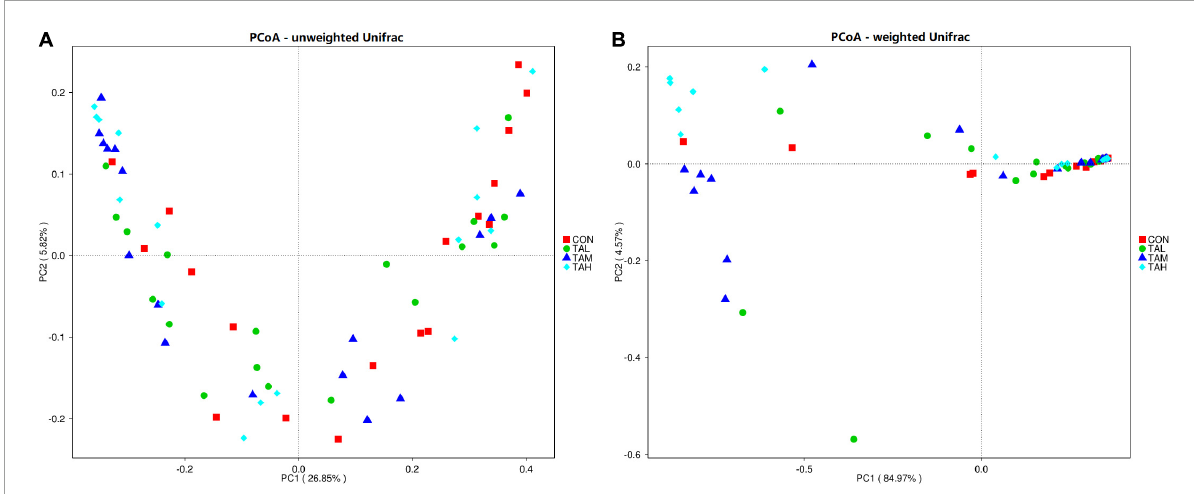
FIGURE1 The principal coordinate analysis (PCoA) plots on rumen bacterial community structure across the four treatments. (A) PCoA based on the unweighted Unifrac matrix. (B) PCoA based on the weighted Unifrac matrix.